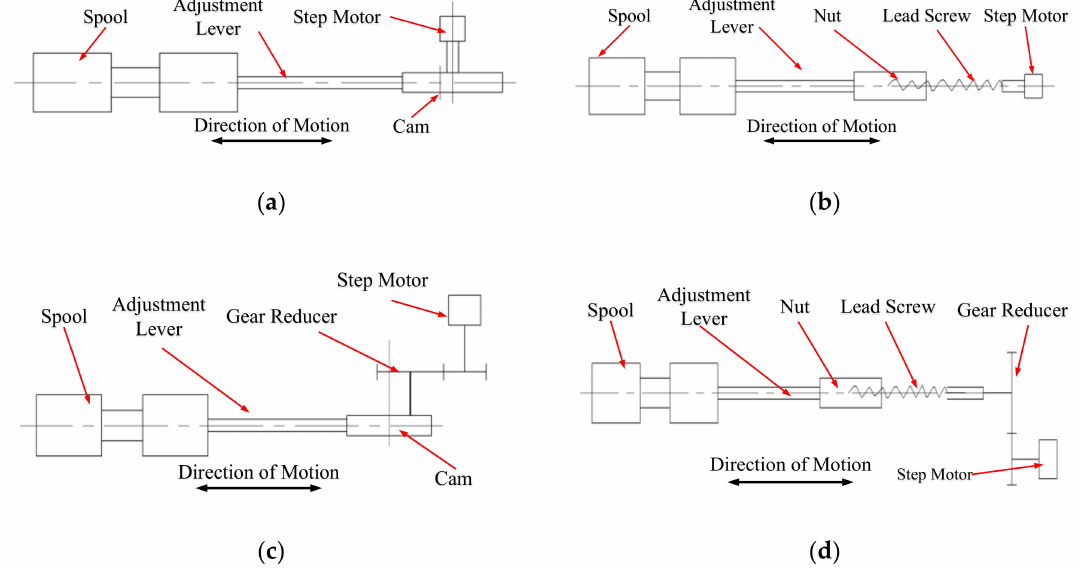
Figure 5. Four typical forms of stepping digital hydraulic valves: ( a ) cam type; ( b ) screw nut type; ( c ) gear reducer-cam type; ( d ) gear reducer-screw nut